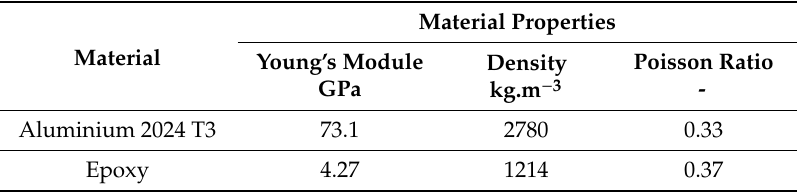
Figure 1. Single lap joint containing double-sided release film debonding: ( a ) prior to bonding top view photo where the right side is perfectly bonded and the left side is with debonding; ( b ) side view schematics. Table 2. Material properties for aluminium adherend and epoxy